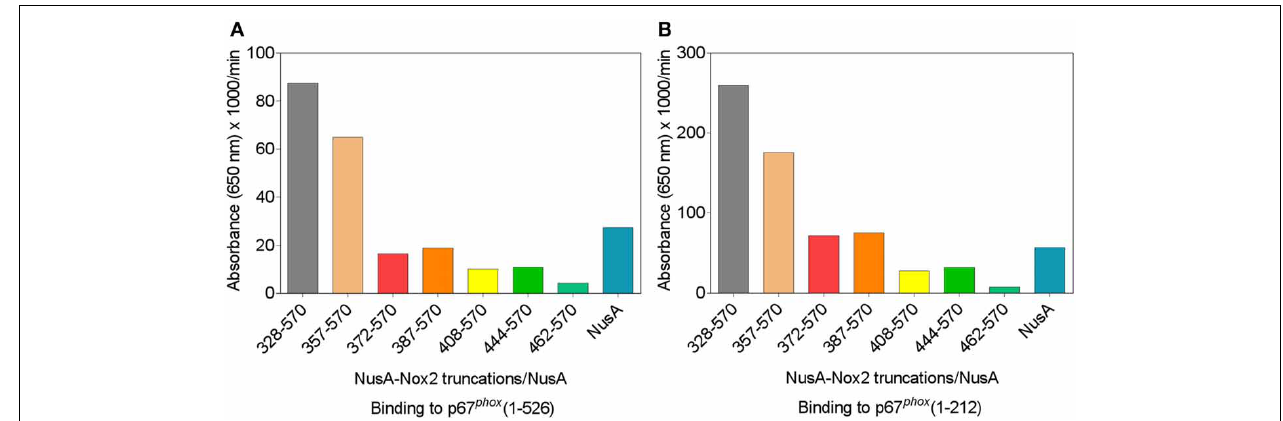
FIGURE 5 | p67 phox (1–526) and p67 phox (1–212) bind to NusA-Nox2(328–570) and NusA-Nox2(357–570) but not to shorter Nox2 truncations. Binding of NusA-Nox2 fusion proteins and NusA, as a control, in the fluid phase, to surface-bound p67 phox (1–526) (A) and p67 phox (1–212) (B) was measured as described in the Materials and Methods Section. All proteins were purified by gel filtration